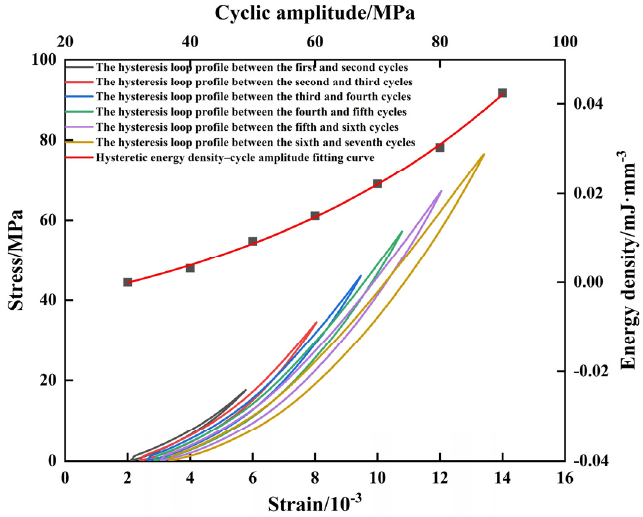
Figure 8. Hysteretic loop profile and hysteretic energy density–cycle amplitude relationship curve.